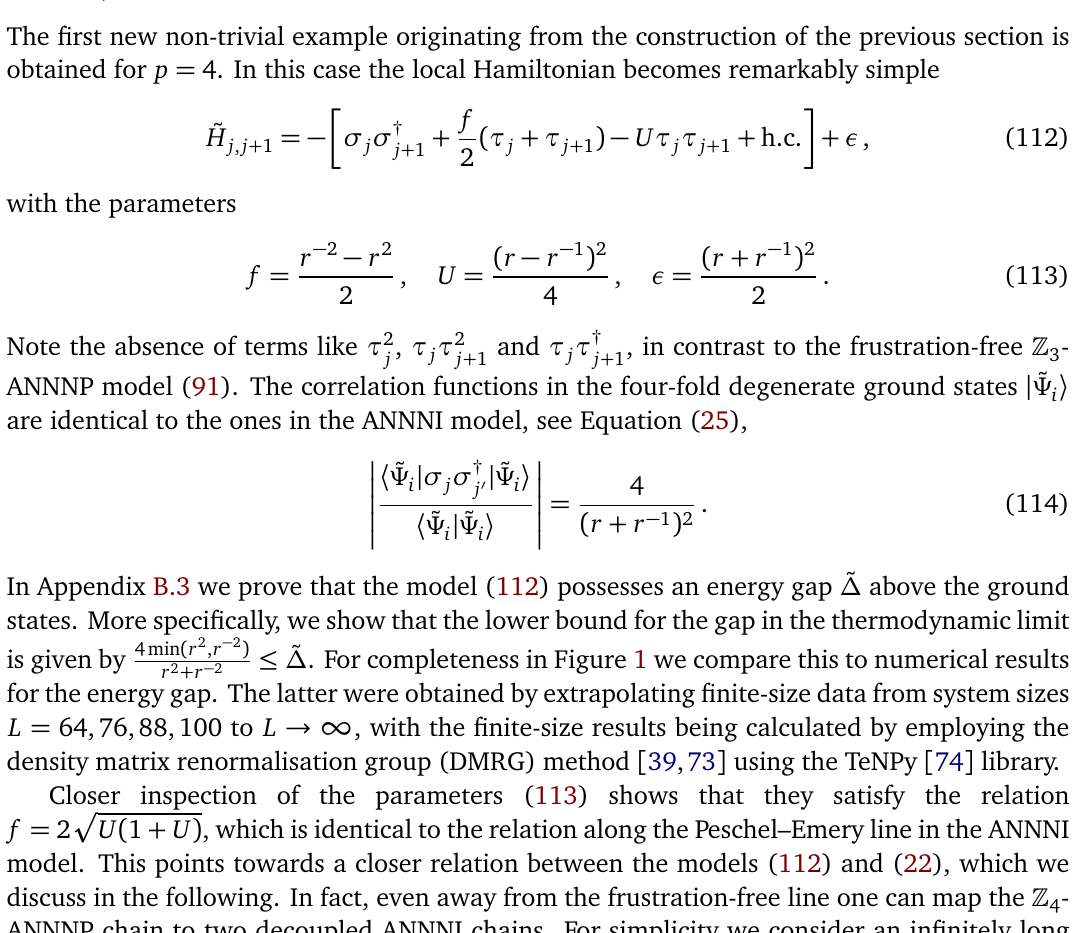
Figure 1: Energy gap ˜ ∆ above the four-fold degenerate ground states | ˜ Ψ frustration-free ANNNP model (112). The dots show the energy gap obtained by extrapolating the finite-size data for L = 64,76,88,100 to the thermodynamic limit. The dashed line is the lower bound for the energy gap proven to exist in Appendix